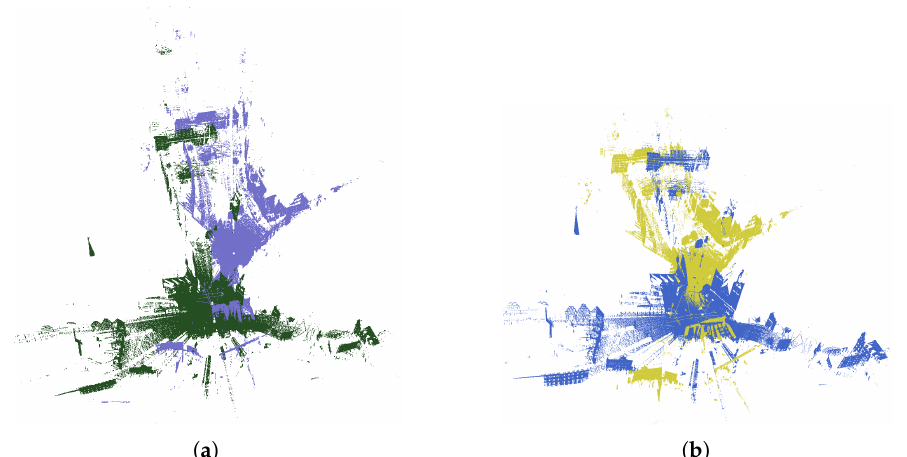
Figure 4. Two point clouds from the Bremen Dataset, to which we applied ( a ) a small translation ( b ) a small rotation.